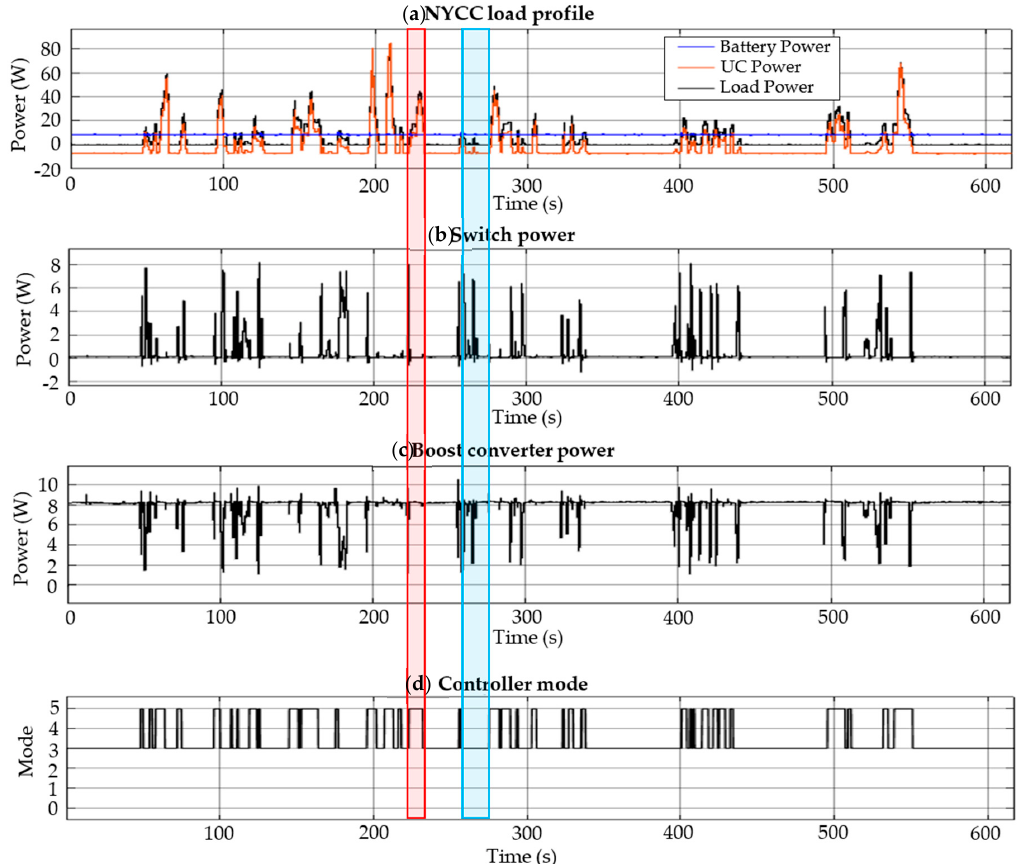
Figure 14. ( a ) NYCC load power distribution; ( b ) Power through the switch; ( c ) Power transferred through the boost converter; ( d ) Controller operating mode.